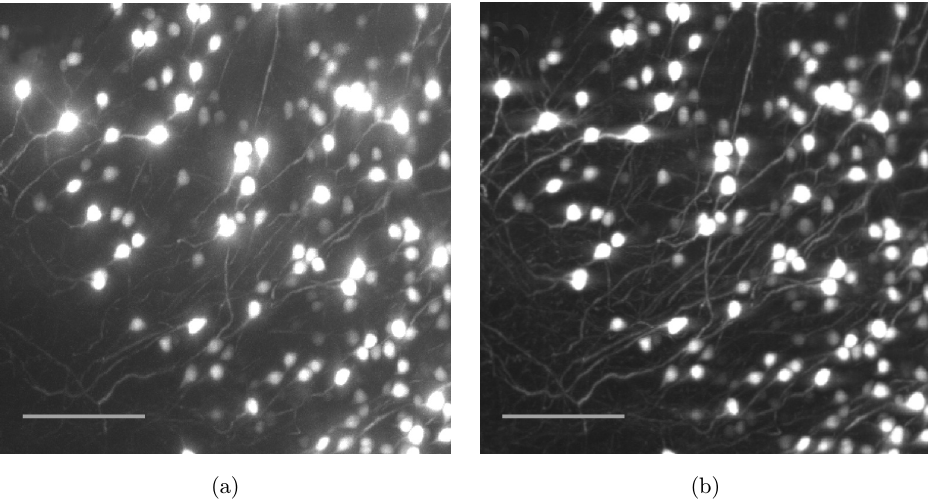
Fig. 4. Contrast enhancement in CLSM. Conventional LSM (a) and corresponding CLSM image (b) of a portion of hippocampus of a thy1-GFP-M mouse (post-natal day 23, PND 23). The EMCCD was overexposed, saturating cell bodies, to better distinguish neurites. Images are maximum intensity projections of 600 sections (z-step 1 (cid:1)